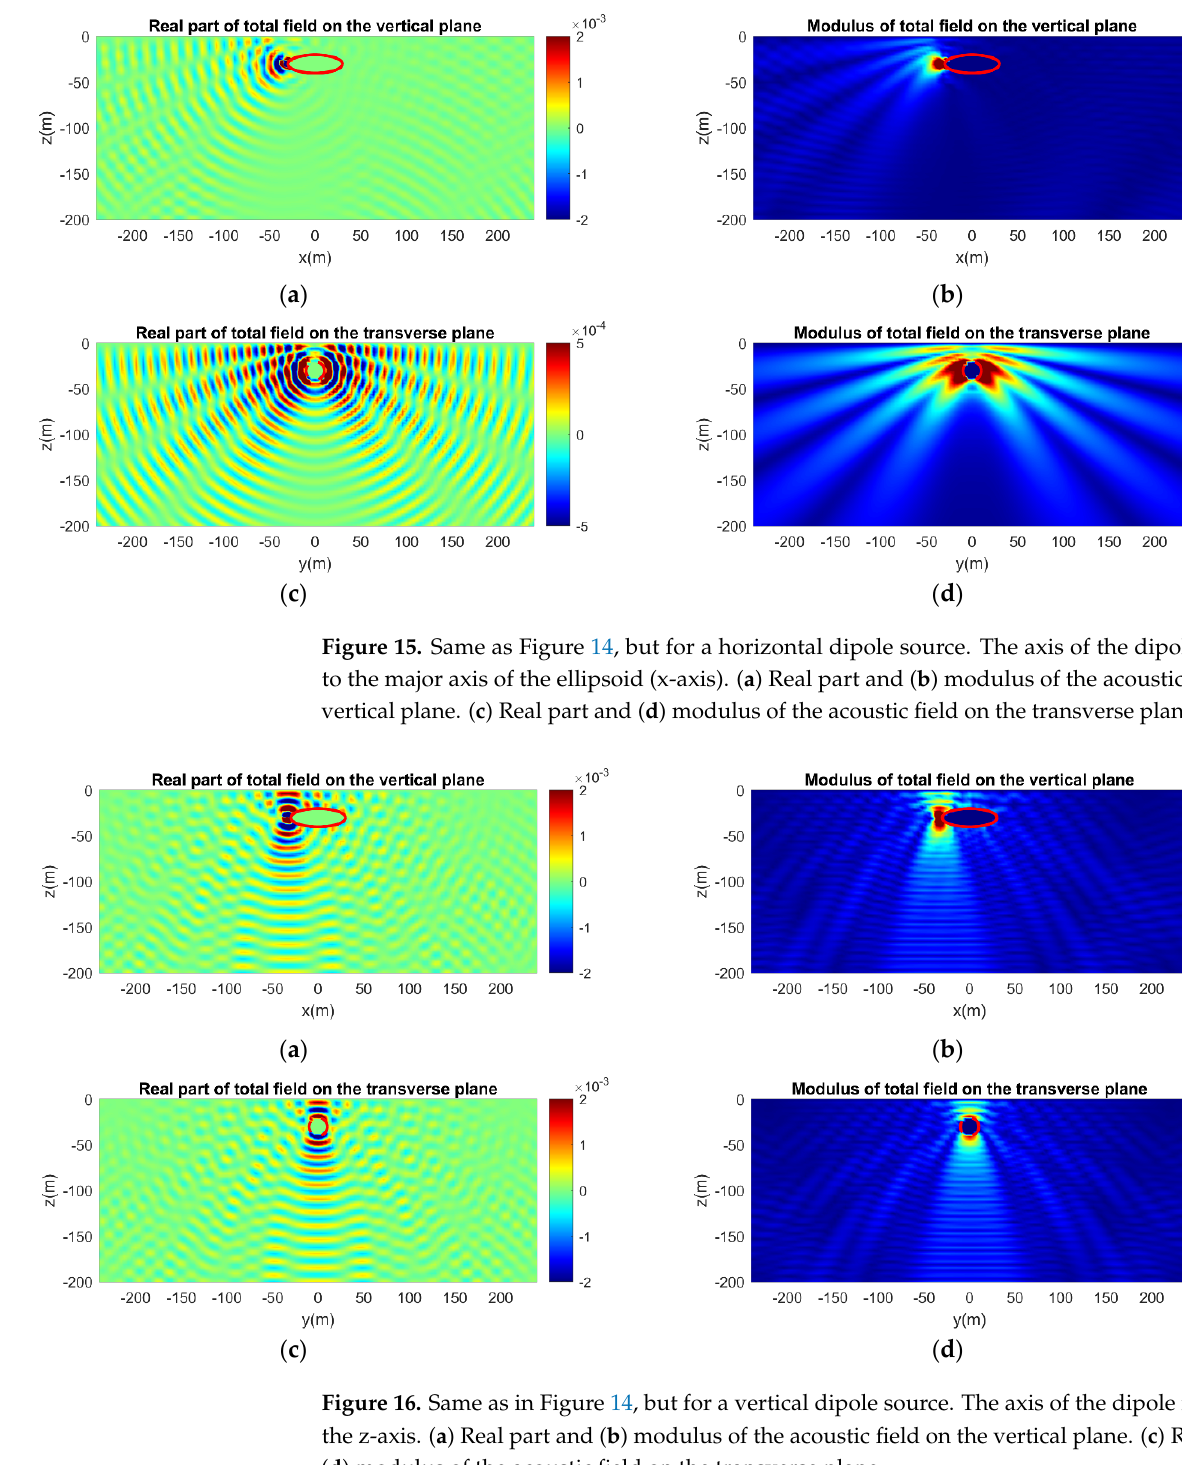
of the acoustic field on the transverse plane.